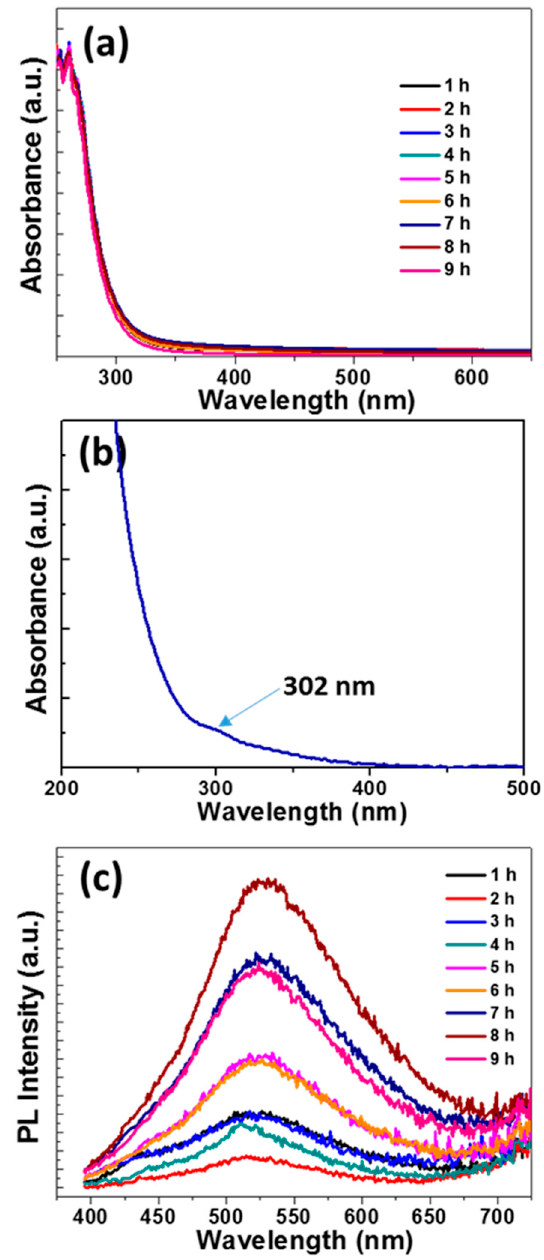
Figure 4. ( a ) Temporal evolution of UV-vis absorption spectra during the synthesis of GQDs and ( b ) magnification of the 200–500 nm range showing the n → π * transition at 302 nm. ( c ) Temporal evolution of photoluminescence (PL) emission spectra during the synthesis of GQDs ( λ ex = 375 nm).